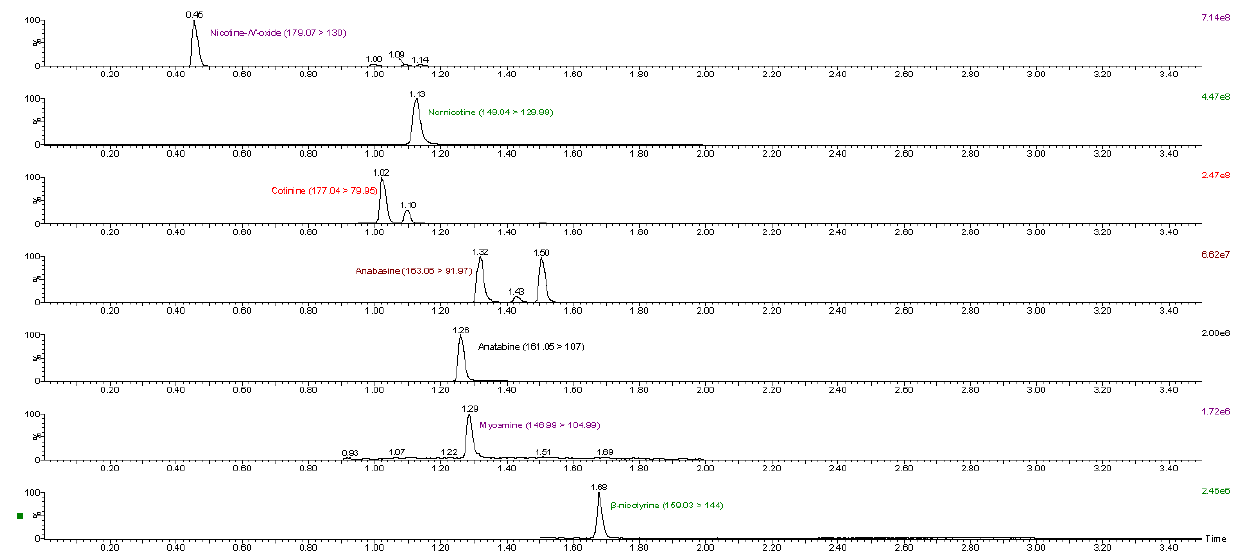
Figure 2. MRM transitions of analytes detected in CRP